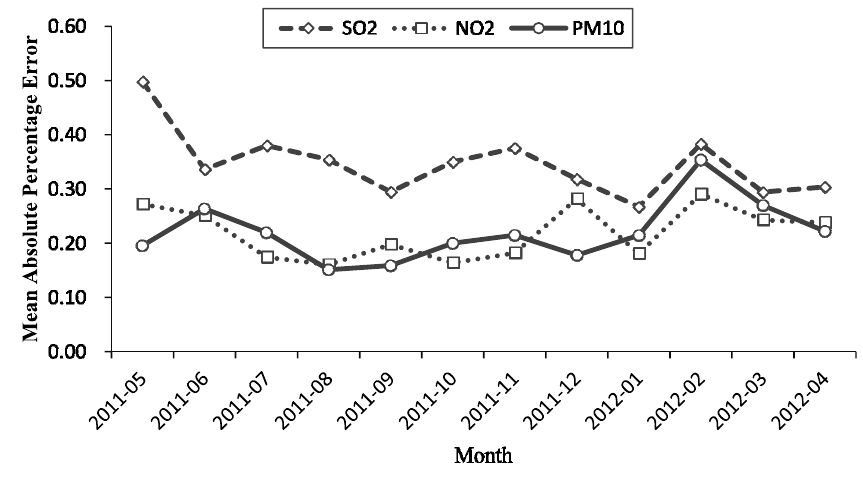
Figure 2. MAPE of models for Num. 2 from May 2011 to April